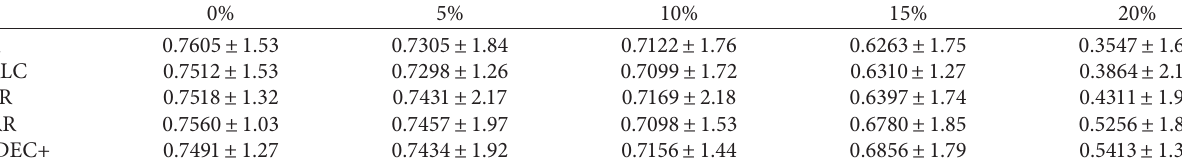
Table 11: Clustering results concerning the accuracy of different algorithms on the LFW